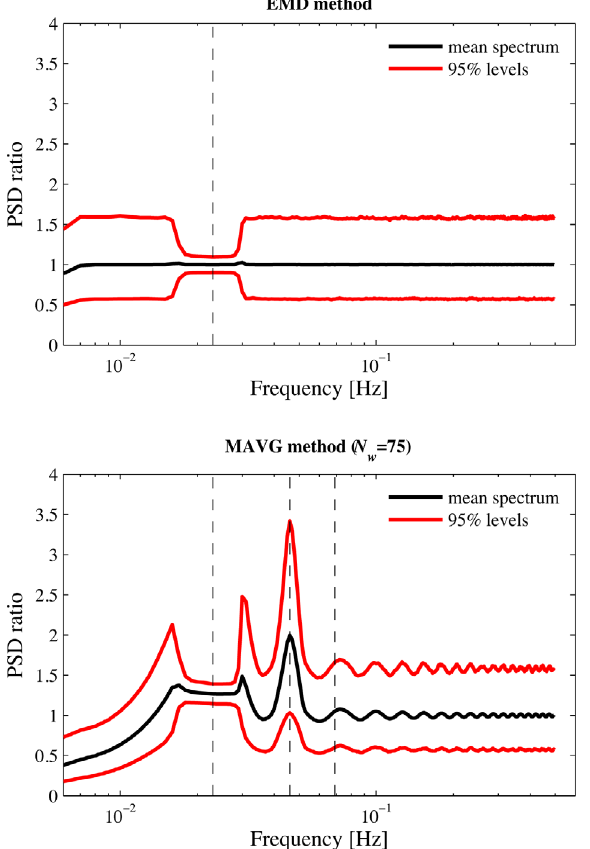
Figure 7. EMD/MAVG comparison: statistical analysis. 10,000 runs average of total PSD ratio between rotated and original sig- nals by the EMD (top panel) and MAVG (bottom panel) methods. Red lines indicate the upper and lower limits of 95% confidence level. Dashed lines indicates the perturbation frequency and its first